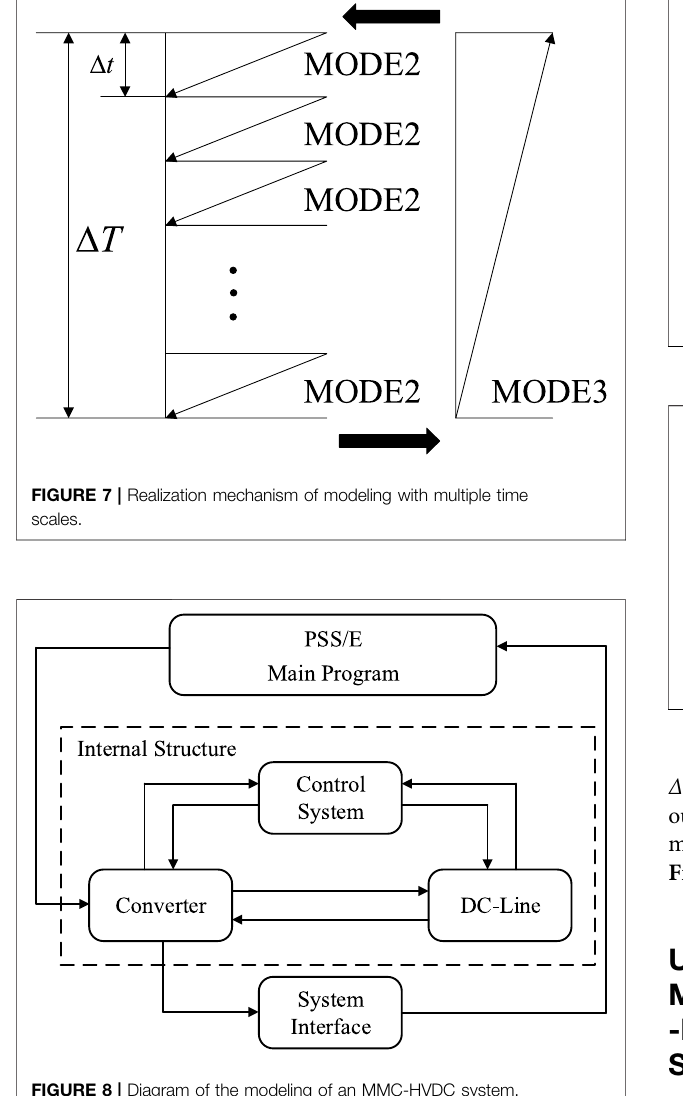
FIGURE 8 | Diagram of the modeling of an MMC-HVDC system.